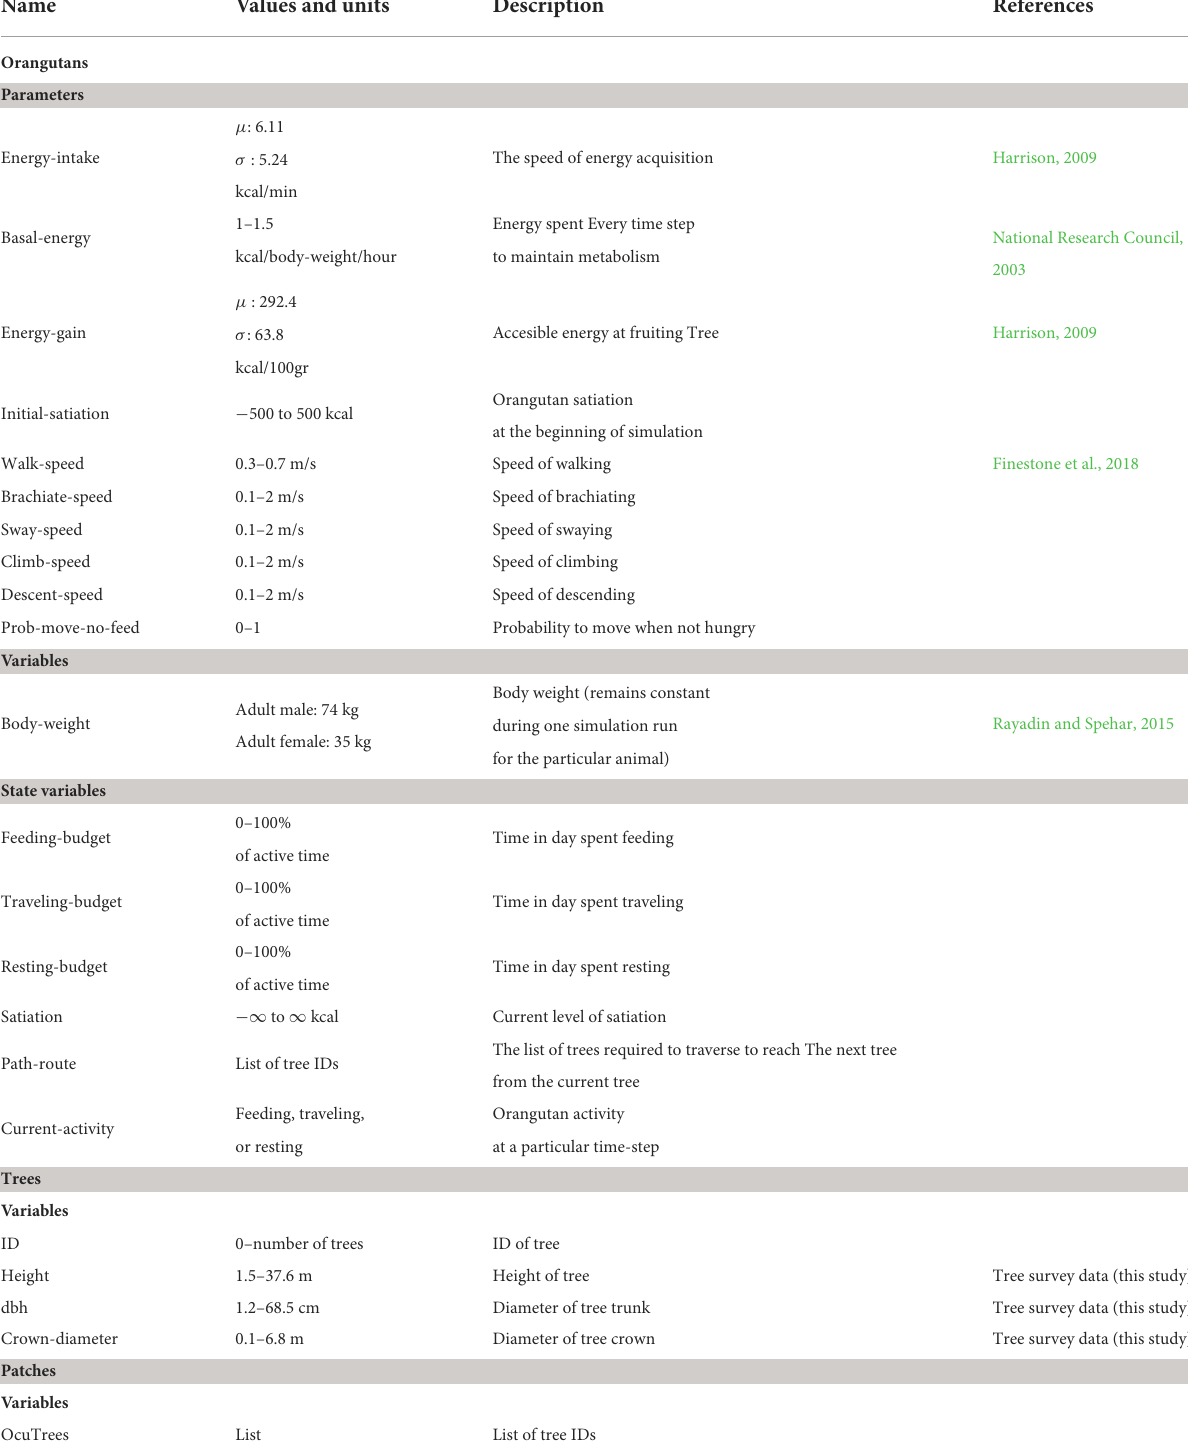
TABLE 1 The BORNEO model describes three entities: orangutans, trees, and